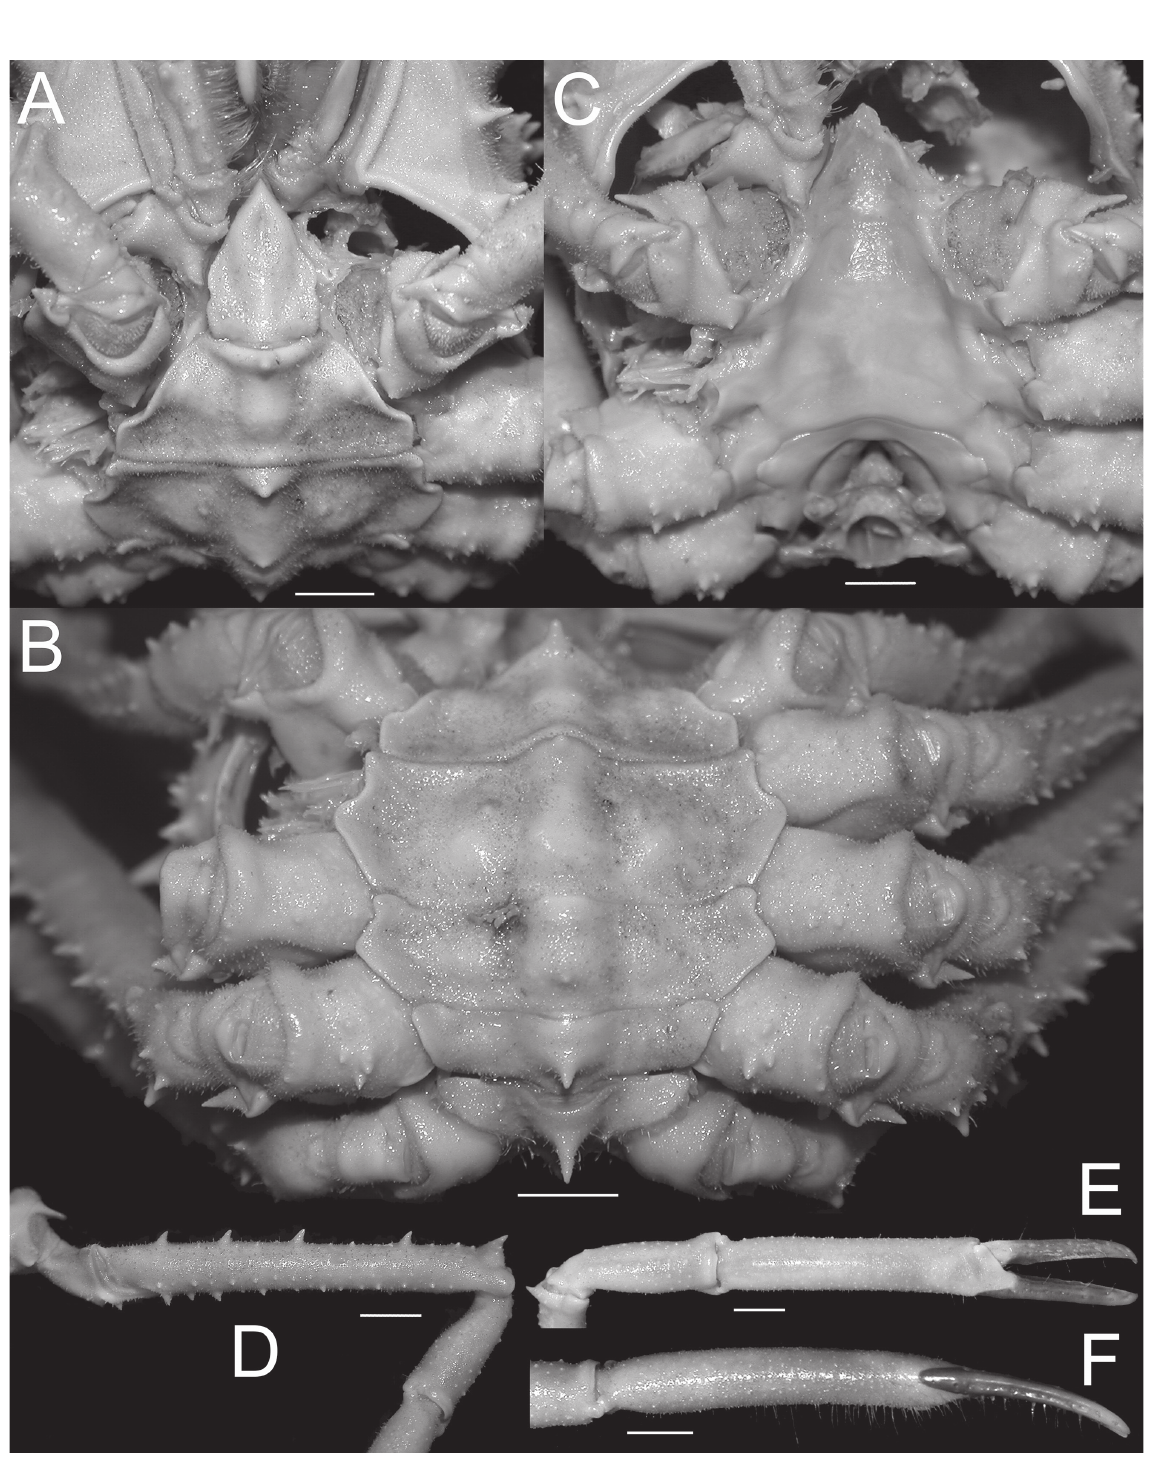
Fig. 6. Moloha grandperrini Guinot & Richer de Forges, 1995. Holotype, ♂ (cl 46.5 mm, cw 39.0 mm) (NHM 1948.9.7.27), Maldives. A . Telson and pleonal somites 5 and 6. B . Pleonal somites 2–6. C . Sternopleonal cavity. D . Merus and carpus of right cheliped. E . Outer view of right chela. F . Ventro- marginal view of right chela. Scale bars =